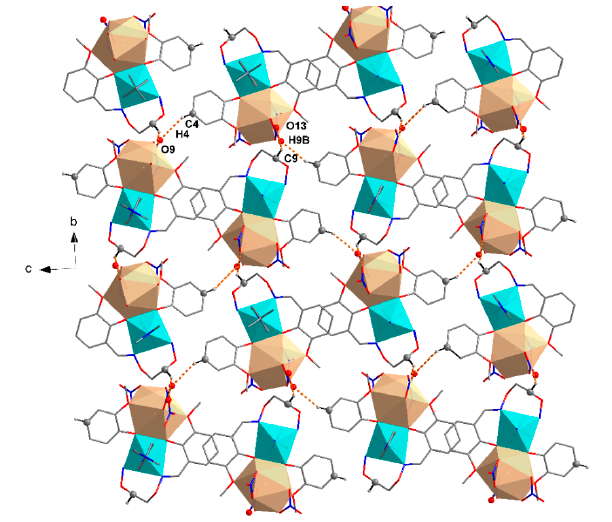
Figure 7. View of the π ··· π stacking interactions.